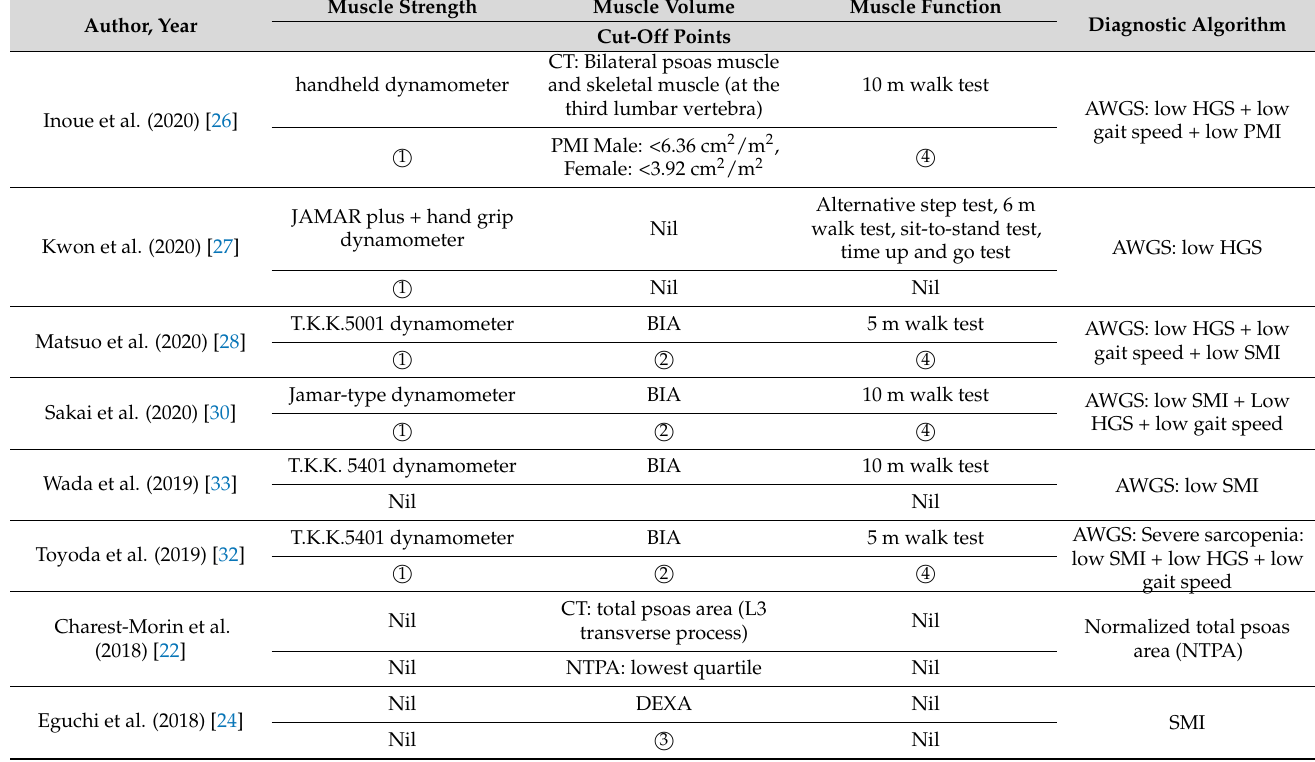
Table 2. Diagnostic Tools and Criteria of Sarcopenia in the Included